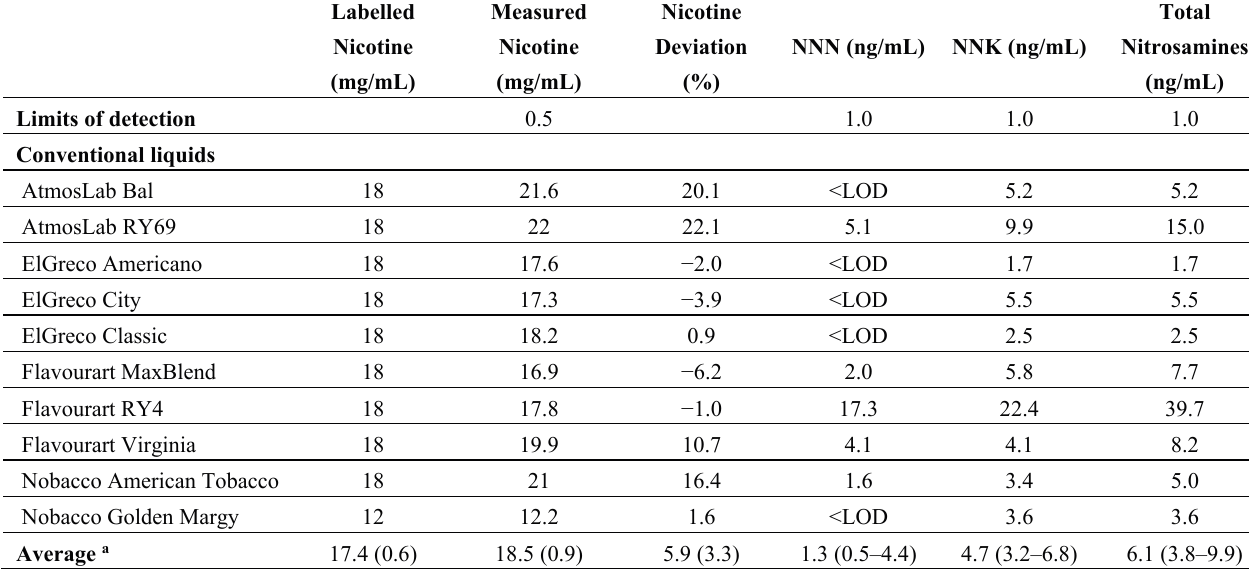
Table 1. Nicotine and tobacco-specific nitrosamines in electronic cigarette liquids produced with conventional flavours or natural extracts of tobacco (NET). Deviation from labelled nicotine level is also